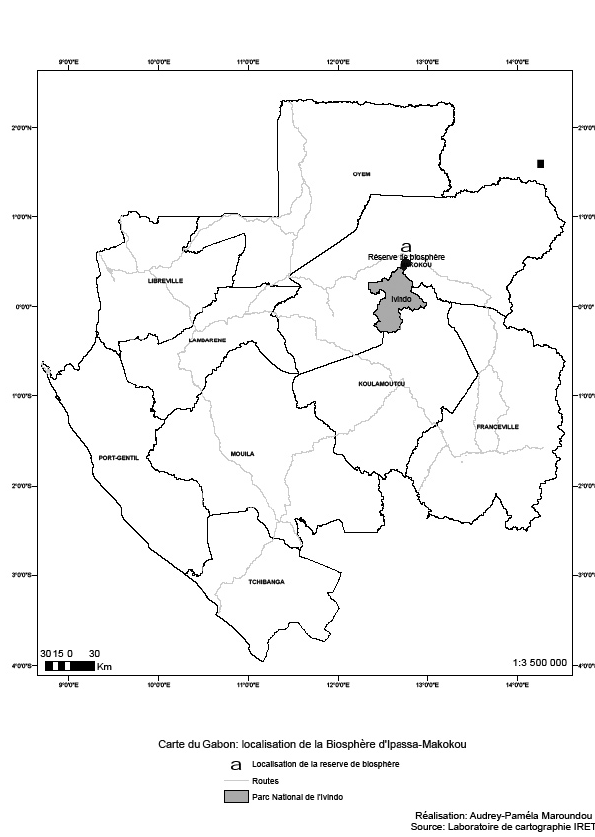
Figure 1. – Représentation du site